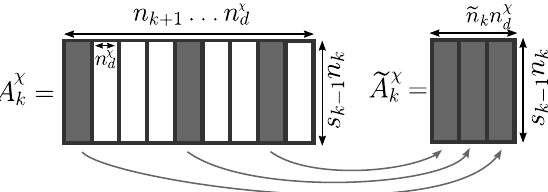
Figure 2. Definition of the submatrix ˜ A χ the snapshot POD sample size is ˜ n k = 3.